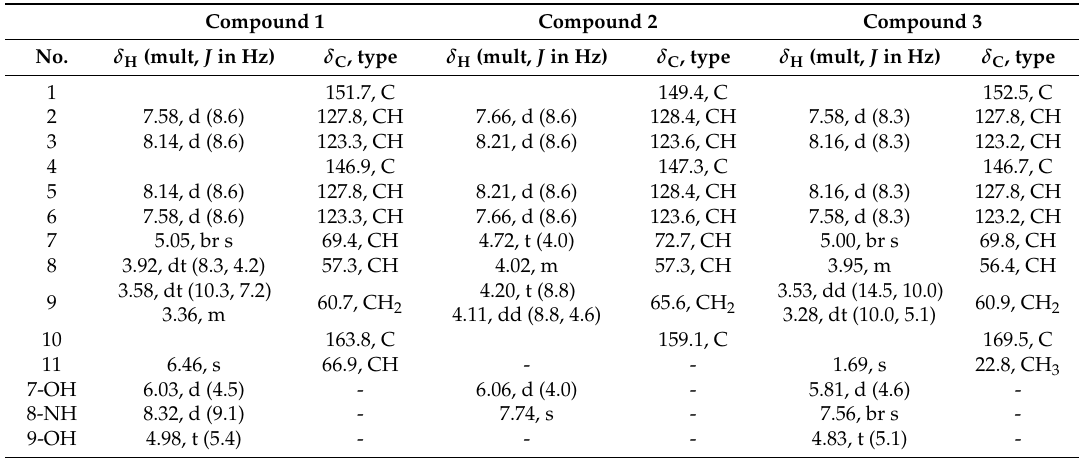
Table 1. 1 H- (500 MHz) and 13 C-NMR (125 MHz) data of compounds 1 – 3 (DMSO- d 6